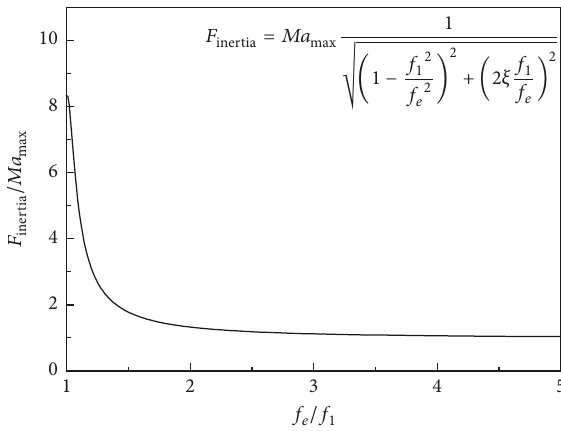
Figure 12: Relation between the ratio of the inertial force of the water 𝐹 inertia and product of the added mass 𝑀 and maximum seismic acceleration 𝑎 max and the ratio of the seismic excitation frequency 𝑓 𝑒 and fundamental frequency of the water body 𝑓 1